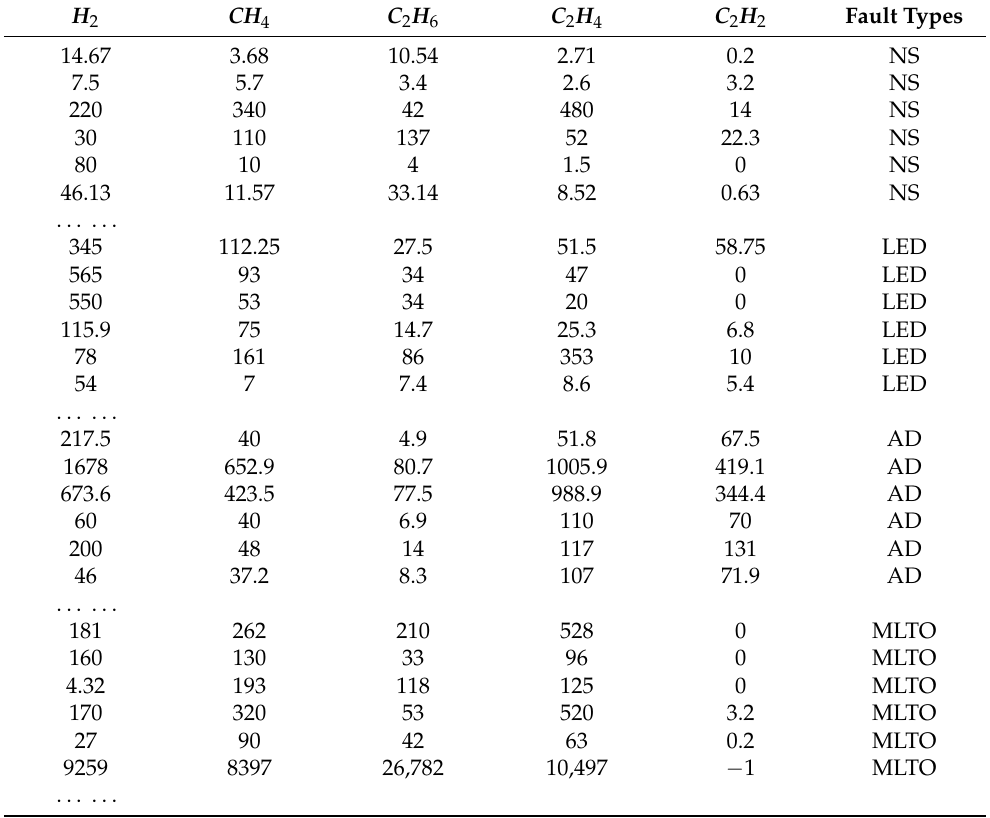
Table 6. Partial sample set of transformer fault diagnosis.